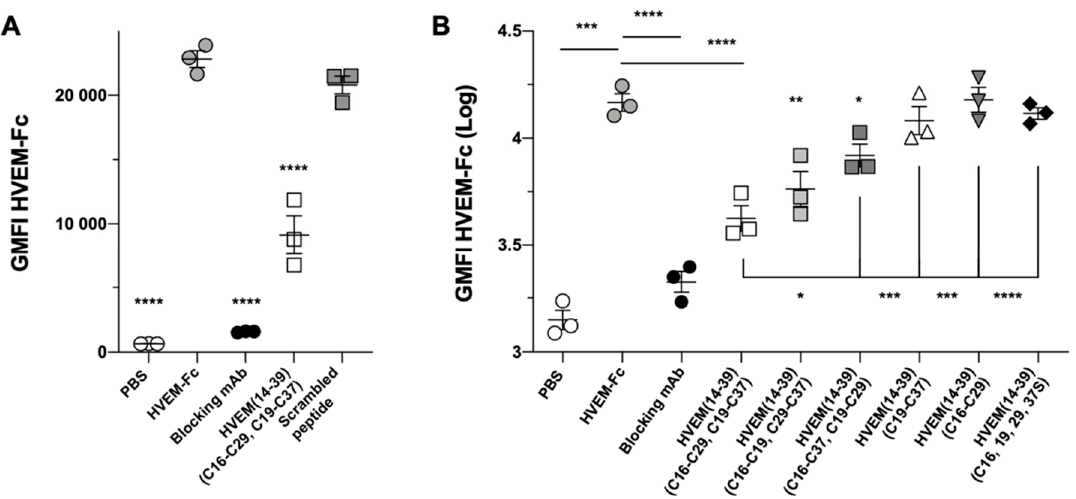
Figure 7. HVEM (14–39) peptide blocks BTLA / HVEM binding. 293T cells expressing human BTLA were incubated with peptides (5 mg / mL) prior to labeling with HVEM-Fc and AF647-conjugated anti-human IgG antibody. The blocking capacity of the HVEM (14–39) peptide was first compared to ( A ) a scrambled (Ac-SECGRCEAPEKTKSLCVTPEPVGCYG-NH 2 ) peptide or ( B ) to variant peptides (Table S2). The graph shows the geometric fluorescence intensity (GMFI). * p < 0.05, ** p < 0.01, *** p < 0.001 and **** p < 0.0001 following one-way ANOVA and Dunn’s post-test, compared to the HVEM-Fc condition in A and HVEM-Fc or native peptide in B.